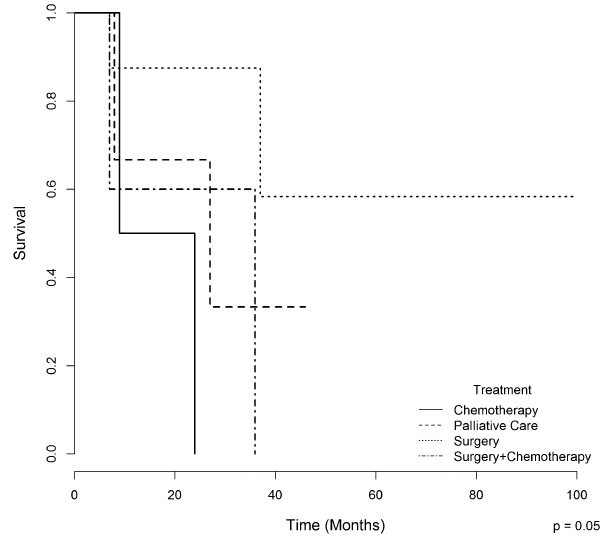
Figure 5 - The overall survival of patients with fibrolamellar hepatocellular carcinoma according to treatment.